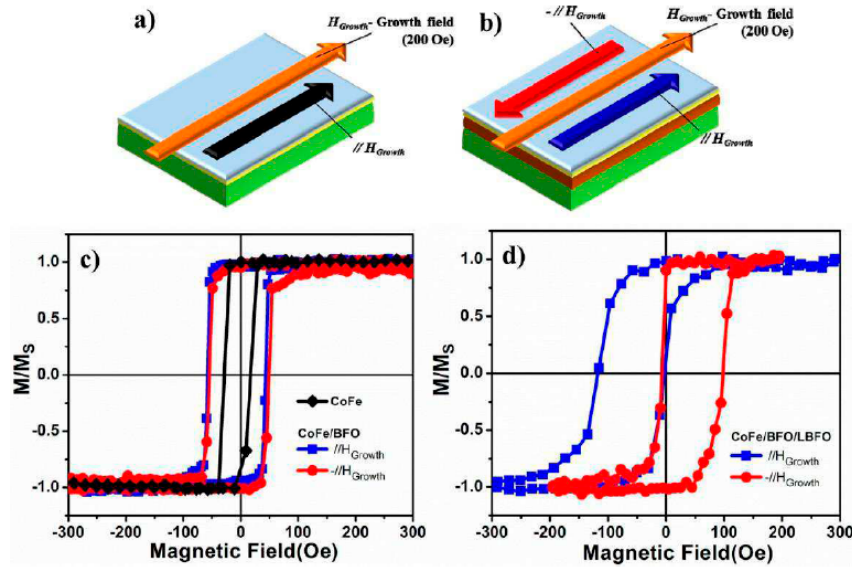
Figure 13. Applied magnetic fields during CoFe growth and measurement of ( a ) CoFe and ( b ) CoFe/BiFeO 3 with or without dielectric LBFO layer; hysteresis loops measured for systems ( c ) without and ( d ) with dielectric layer. Reprinted with permission from [125], Copyright 2017 American Chemical Society.